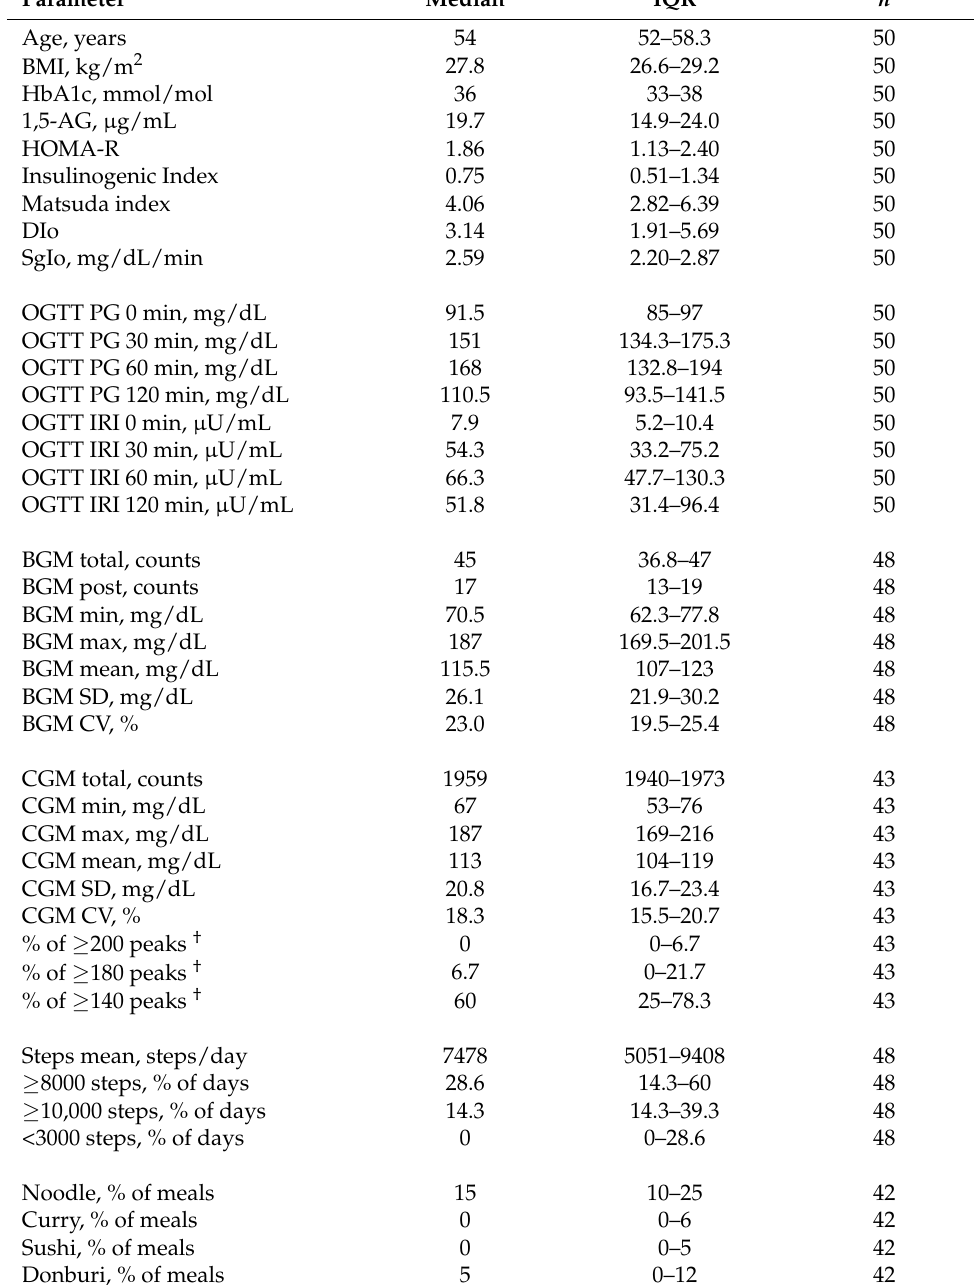
Table 1. The median and interquartile range of the anthropometric, lifestyle, or biochemical